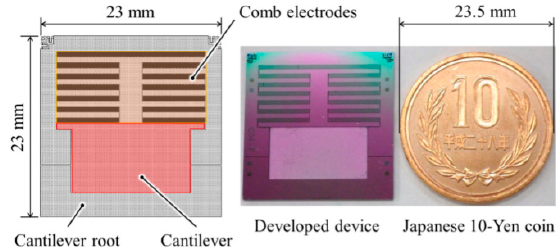
Figure 3. A photograph of the applied vibration-based micro energy harvester (MEH) device (Device size is 23 × 23 mm) [22].